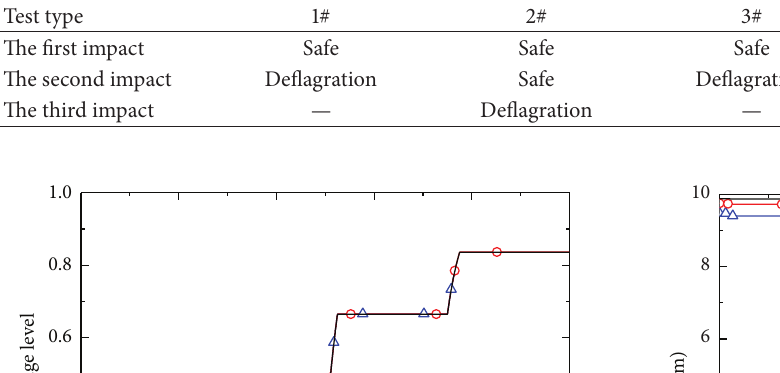
Table 2: Results of multi-impulse impact tests of pressed PBX charge [20].